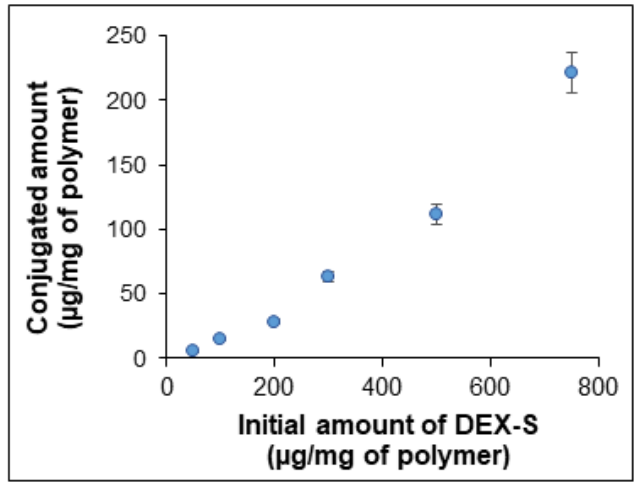
D,L -1 sample was investigated de-